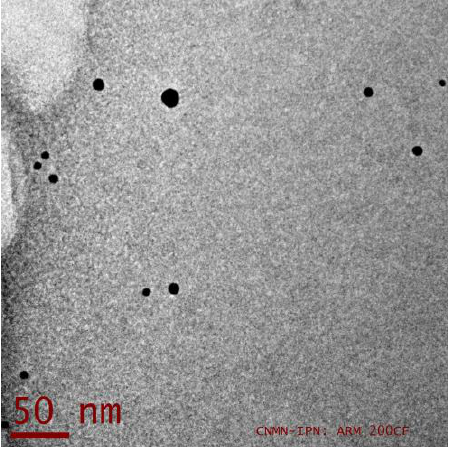
Figure 3. Representative micrograph of the Au-Pt NPs analyzed by TEM.